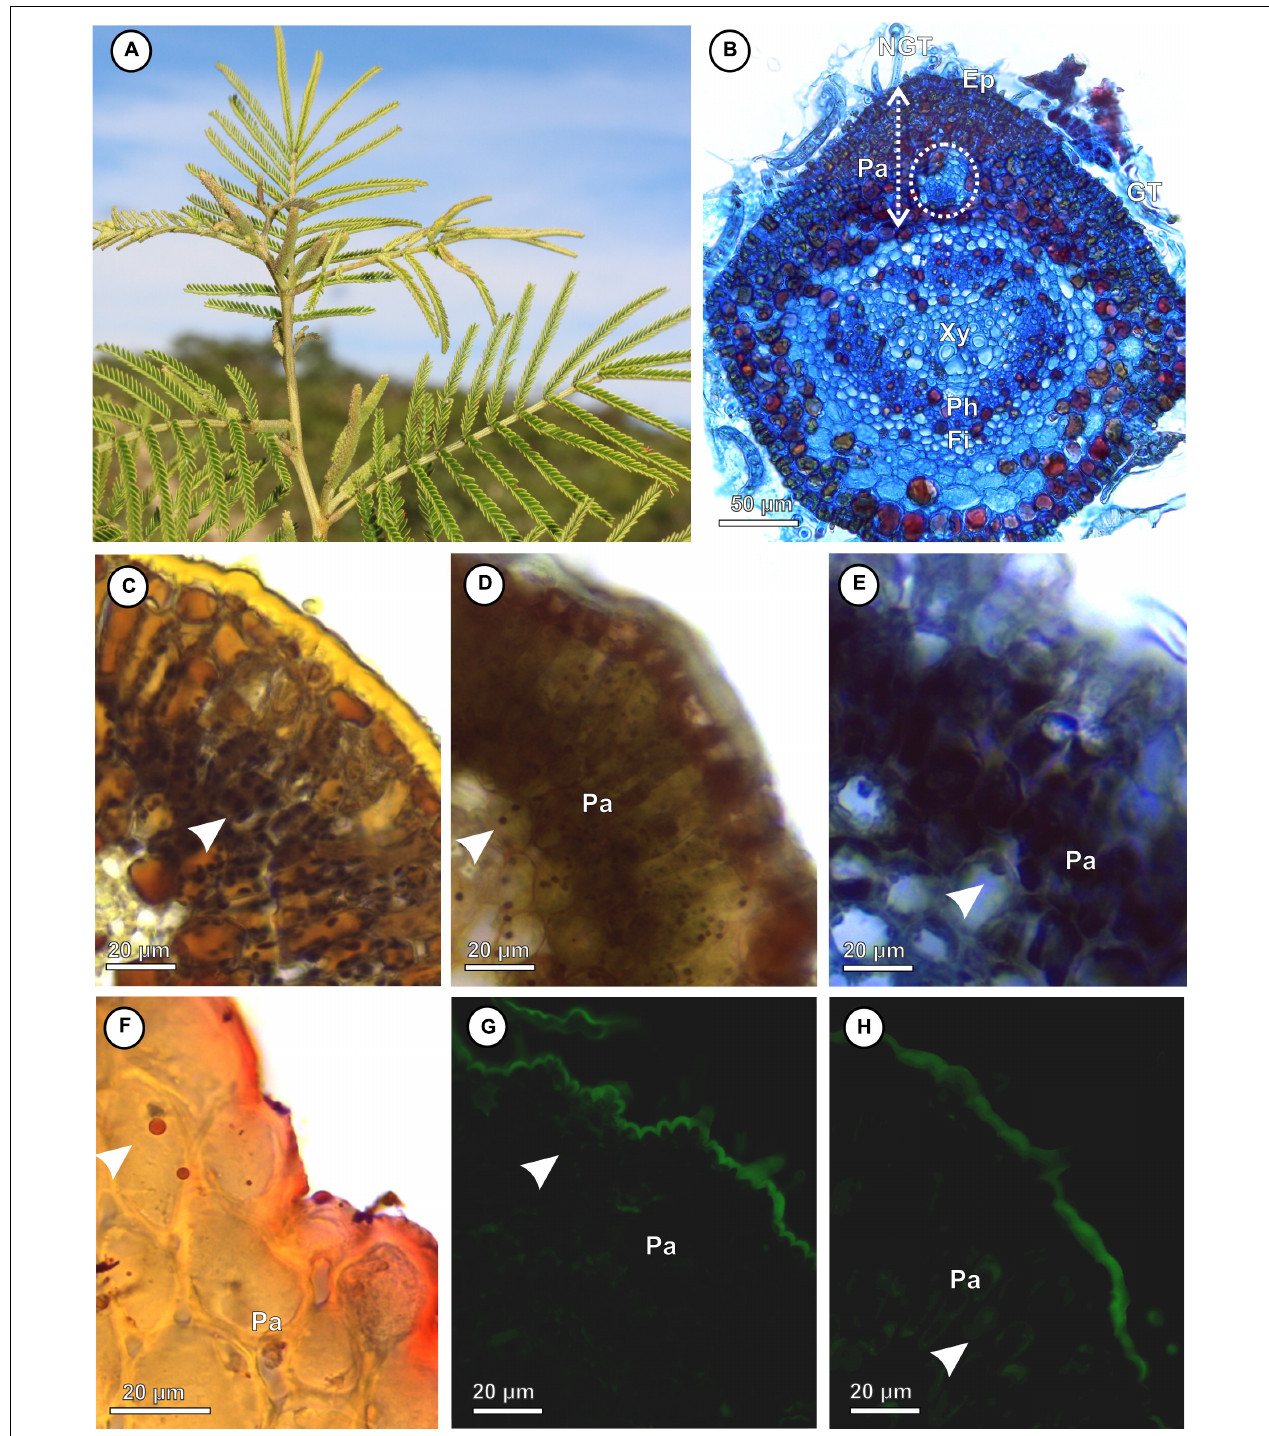
FIGURE 1 | Non-galled pinna-rachis of Mimosa gemmulata Barneby (Fabaceae). (A) General aspect of non-galled leaves. (B–H) Transverse sections. (B) Anatomical profile. (C,D) Immunocytochemical profile. (C–F) Histochemical profile. (C) Starch grains stained in black (white arrowhead). (D) Reducing sugars stained in brown (white arrowhead). (E) Proteins stained in blue (white arrowhead). (F) Lipidic droplets stained in red (white arrowhead). (G,H) Xyloglucans detected by LM15 in cell walls of parenchyma (white arrowhead). (H) Heteromannans detected by LM21 in cell walls of parenchyma (white arrowheads). Ep, Epidermis; Fi, fibers; GT, glandular trichomes; NGT, non-glandular trichomes; Pa, parenchyma; Ph, Phloem; Xy, Xylem.